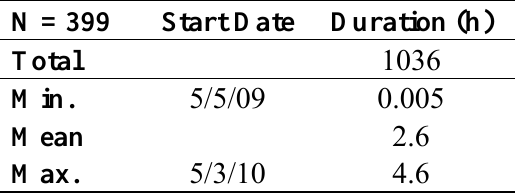
Table 5. Charging behavior summary.